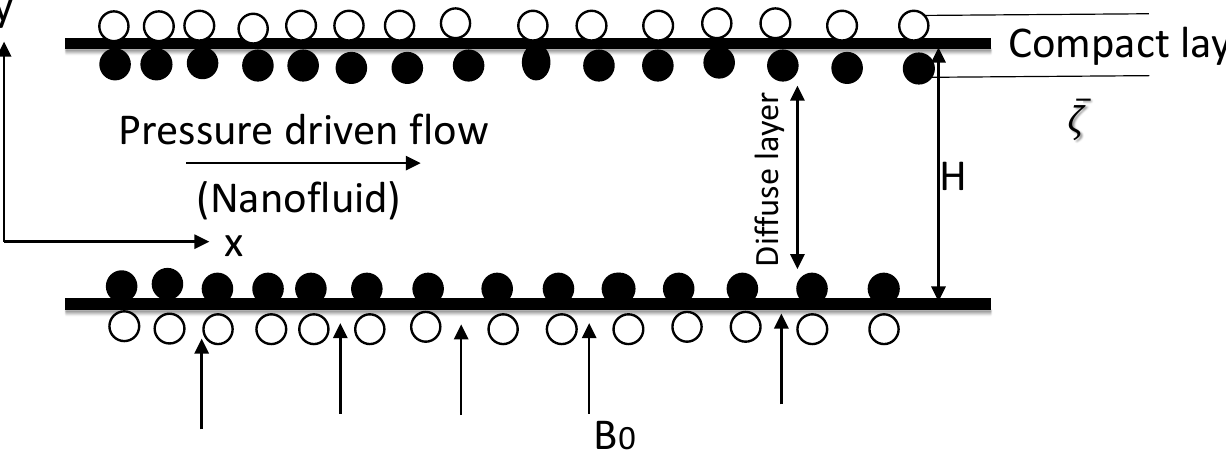
Figure 1. A schematic of the